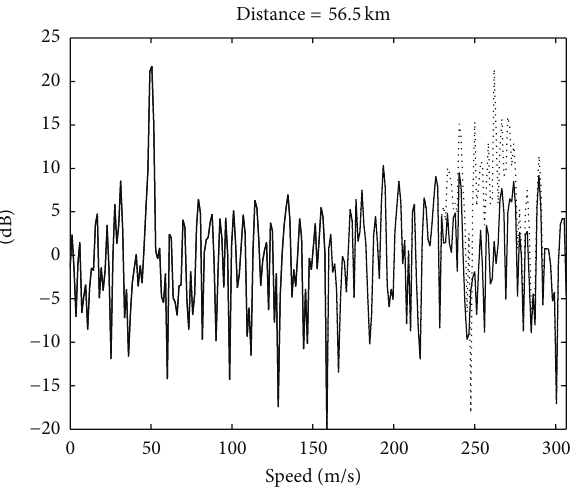
Figure 18: Range-Doppler map of the air-air simulated data show- ing the performance of Stop-Band STAP processing.